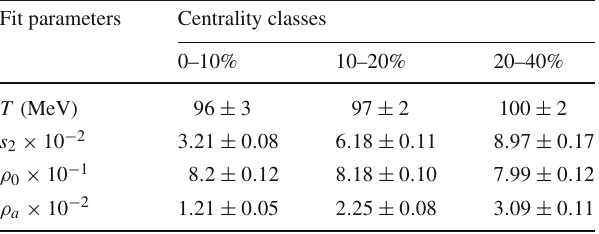
Table 3 Blast-Wave parameters computed by fitting the pion, kaon and proton transverse-momentum spectra and elliptic flow. See the text for more